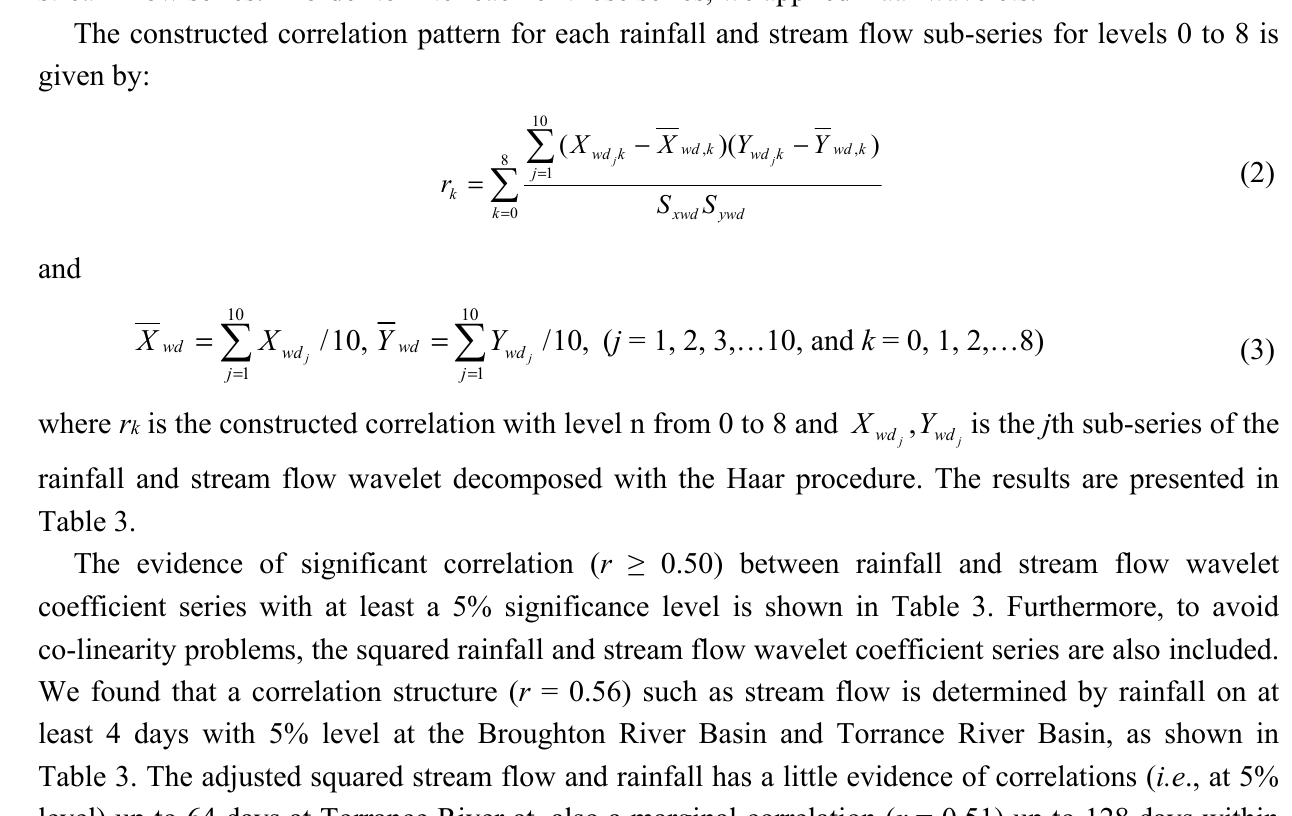
Table 3. The adjusted squared stream flow and rainfall has a little evidence of correlations ( i.e ., at 5% level) up to 64 days at Torrance River at, also a marginal correlation ( r = 0.51) up to 128 days within squared adjusted rainfall and adjusted stream flow at Wakefield River. The rainfall and stream flow relationship was used to develop a response model for predicting stream